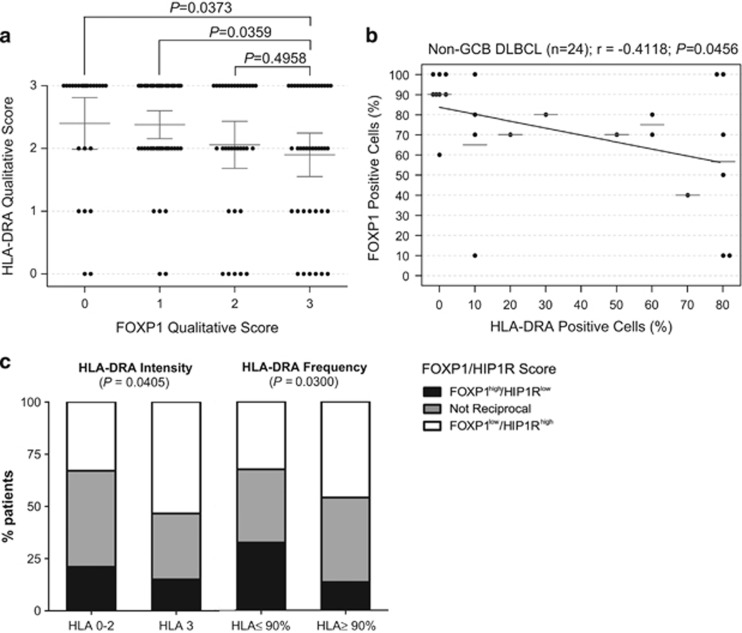
Relationships between the expression of HLA-DRA, FOXP1 and the FOXP1 target HIP1R in primary DLBCL. (a) Qualitative scoring of the intensity of FOXP1 and HLA-DRA labeling identified significant inverse relationships between these molecules. DLBCL with no loss of HLA-DRA expression exhibited a significantly higher number of cases with lower FOXP1 scores (P=0.0373). (b) Significant inverse correlation between FOXP1 and HLA-DRA (<90% frequency expression) in non-GCB DLBCL cases (n=24) was observed in frequency (r=−0.4118; P=0.046) category. (c) Reciprocal expression of FOXP1/HIP1R, used as an indicator of FOXP1S transcriptional activity, significantly correlated with both qualitative and quantitative HLA-DRA scores.